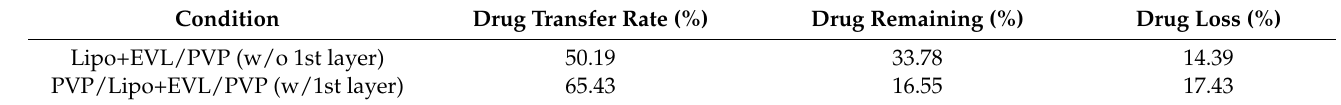
Figure 8. Ex vivo study for drug transfer on the tissue from multilayer-coated film. ( A ) Customized set-up to simulate drug transfer on the tissue from multilayer-coated film. ( B ) The fluorescence images for drug transfer to the tissues according to the presence of the 1st layer PVP (Red: Nile red-labeled liposome; The size of film is 20 mm × 12.48 mm). Table 2. Comparisons of drug transfer rate from ex vivo